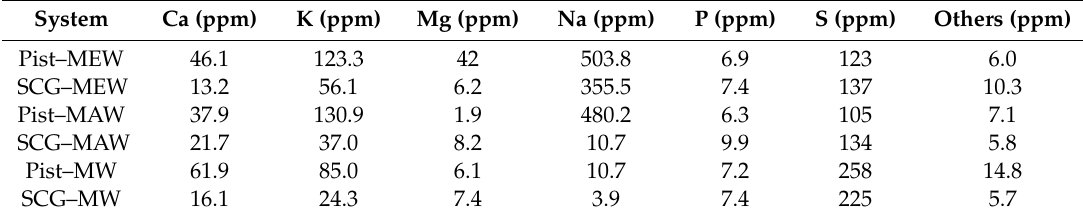
Table 1. Summary of inductively coupled plasma optical emission spectrometry (ICP-OES) results performed to HEF samples.